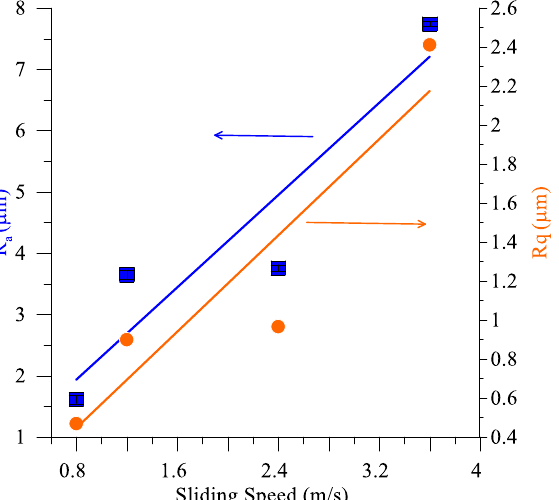
Figure 7. Arithmetical mean and root mean square deviations of worn surface roughnesses, Ra and Rq, resp of M2/W coating after different sliding speeds.